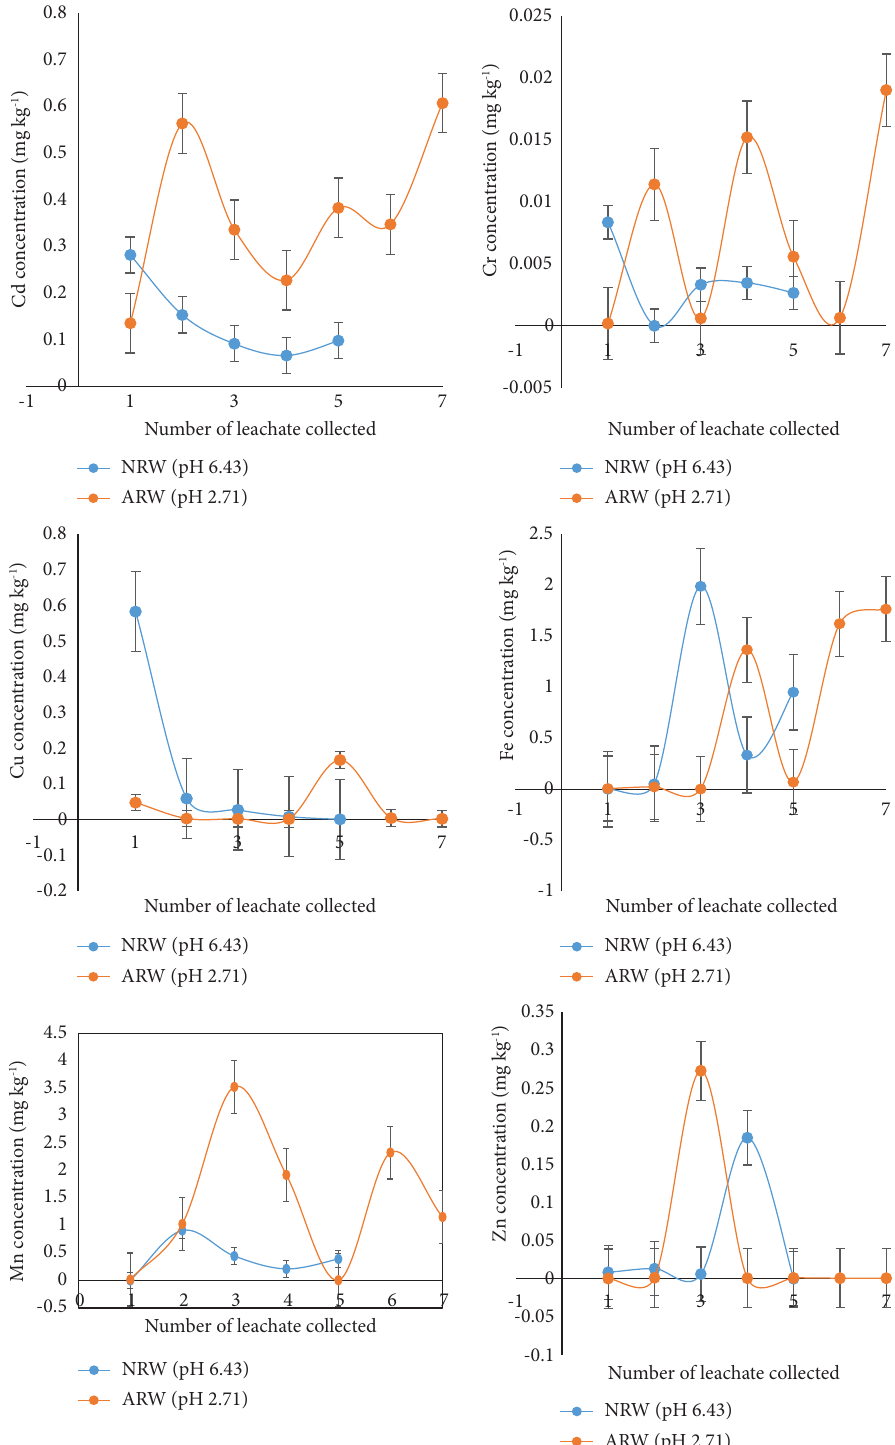
Figure 4: Efects of NRW and ARW on metal concentrations in leachate from soil